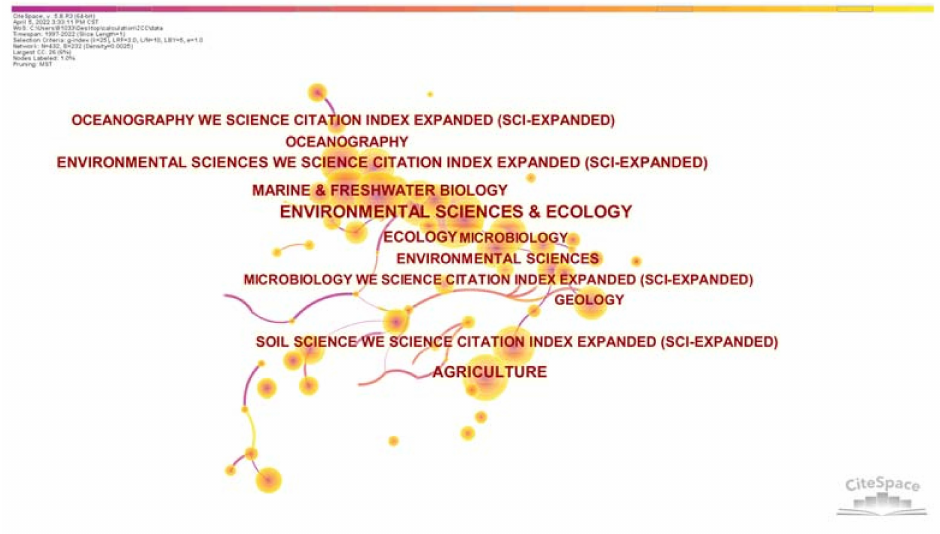
Figure 7. Co-occurrence network of research